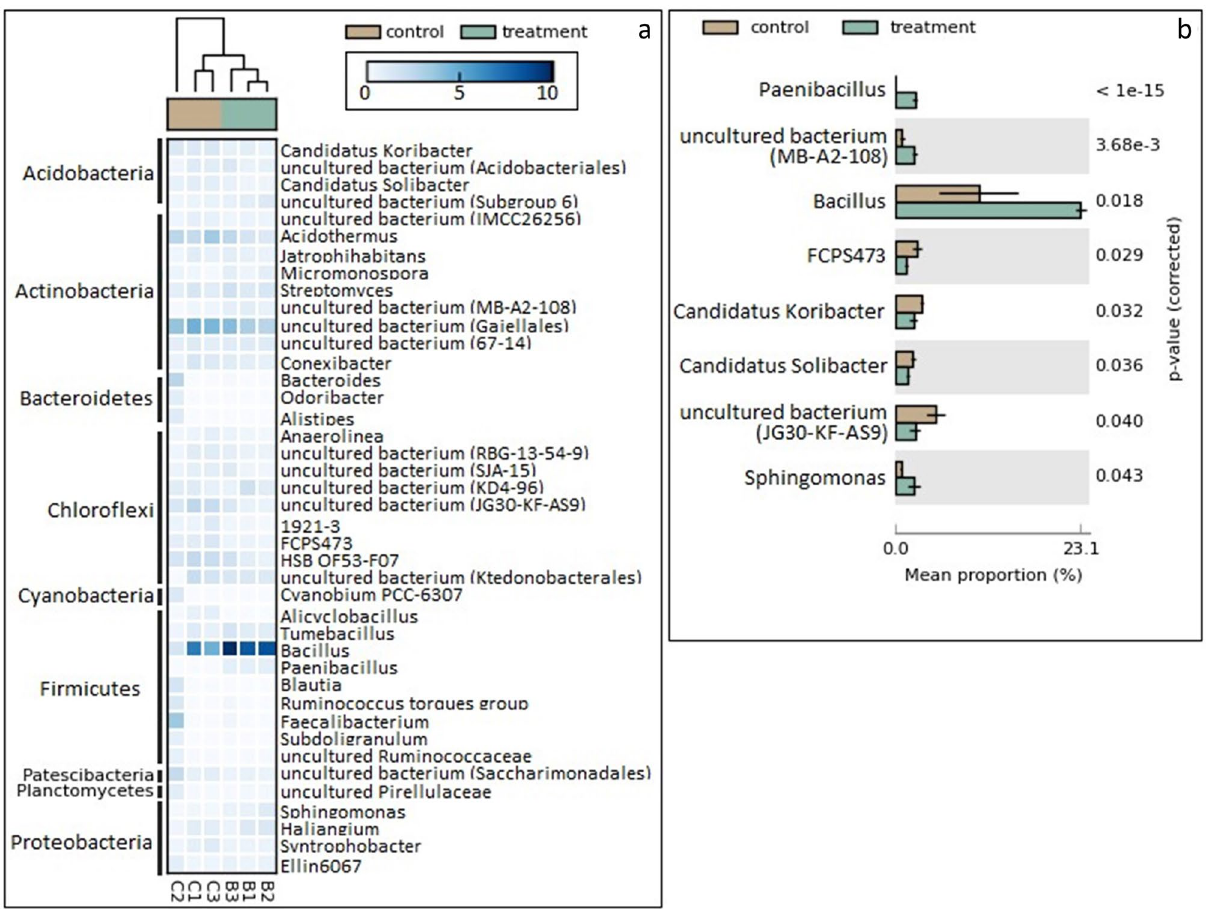
Figure 3. ( a ) Clustered heat map of bacterial profiles at the genus level between soil with and without biochar. ( b ) The difference in the mean proportion of bacterial genus (White’s non-parametric t-test; P-value <